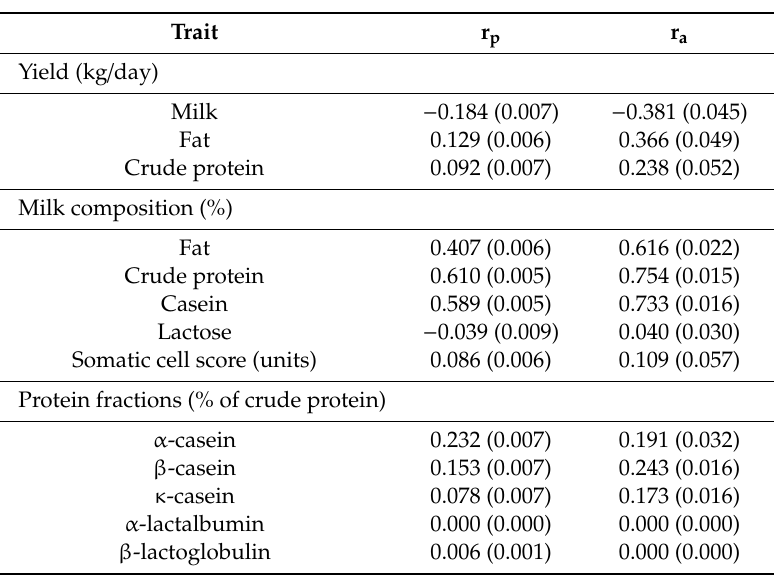
Table 3. Phenotypic (r p ) and genetic (r a ) correlations of bovine milk predicted total antioxidant activity with yield and composition traits, somatic cell score, and protein fractions. Standard errors are given in